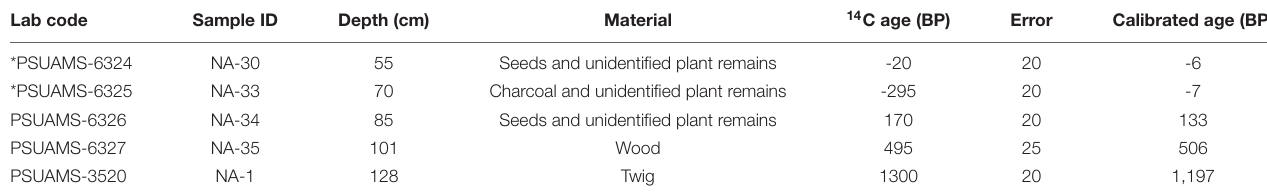
TABLE 1 | AMS Radiocarbon dates used to construct the age-depth model for Namonte core 22-IX-17-1B, southwest Madagascar.